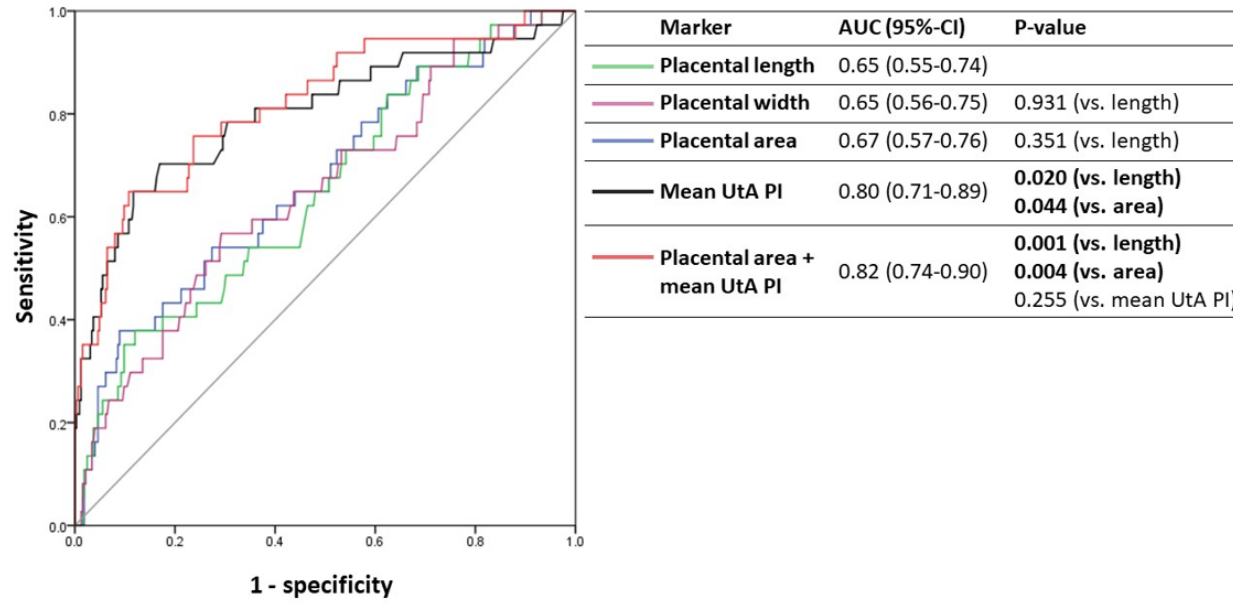
Figure 3. ROC curves of the sonographic placental markers for the prediction of placental complica- tions. The ROC curves for the prediction of the primary outcome are shown for each of the following placental markers (expressed in MoM): placental length (green line), placental width (purple line), placental area (blue line), mean uterine artery PI (black line), and a combination of placental area and mean uterine artery PI (red line). AUC, area under the curve; ROC, receiver operating characteristic; MoM, multiples of median; PI, pulsatility index; UtA, uterine artery. Table 4. Predictive accuracy of placental area and uterine artery for the primary